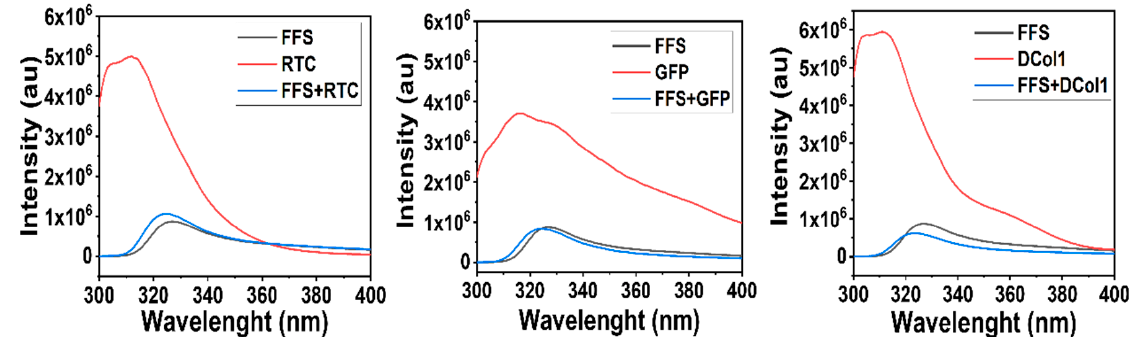
Figure 3. Fluorescence spectroscopy spectra of Fmoc-FF/S peptide (grey), collagen (red) and Fmoc- FF/S-collagen solutions (blue) prepared in PBS (pH = 7.4). Excitation wavelength 280 nm; emission wavelength recorded within the 300–450 nm range.